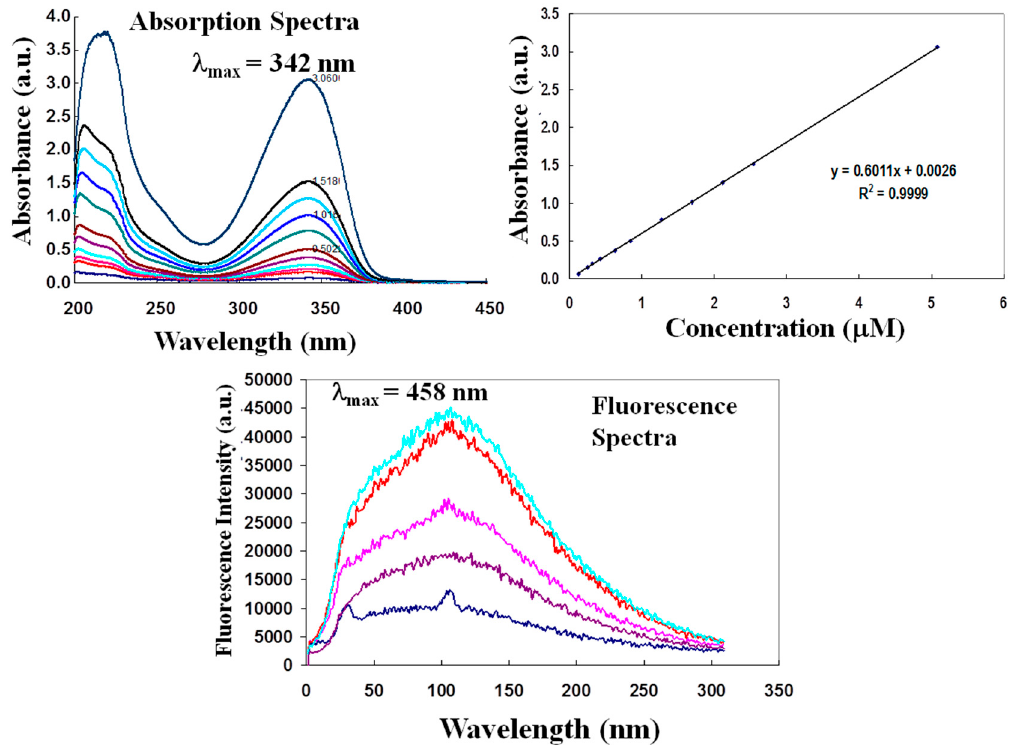
Figure 7. Optical absorption and fluorescence spectra of ionic polymer P-1 in methanol (concentration = 10 − 6 –10 − 4 M).